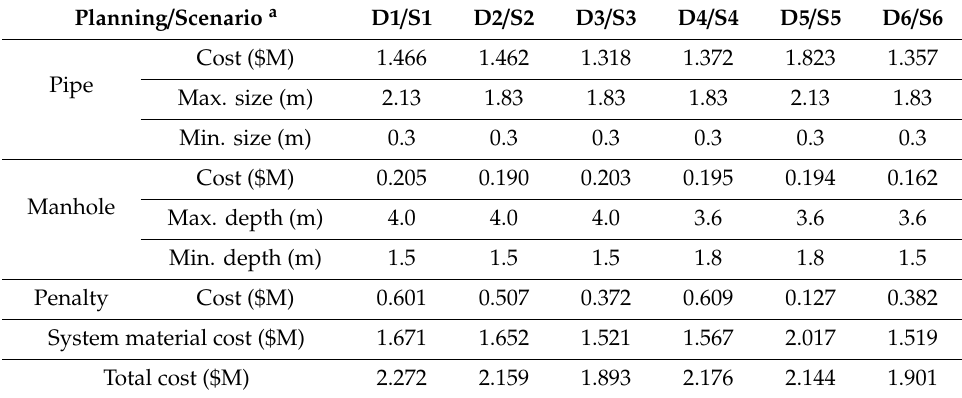
Table 1. Scenario-optimal designs for multiple future